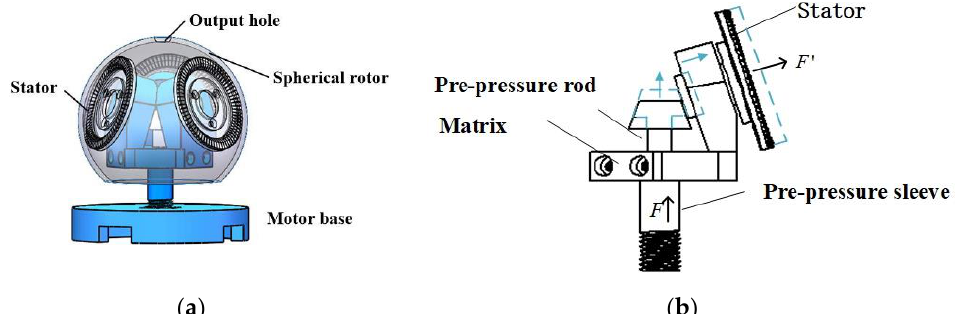
Figure 1. Schematic diagram of motor structure and pre-pressure device. ( a ) Motor structure. ( b ) Pre-pressure device.